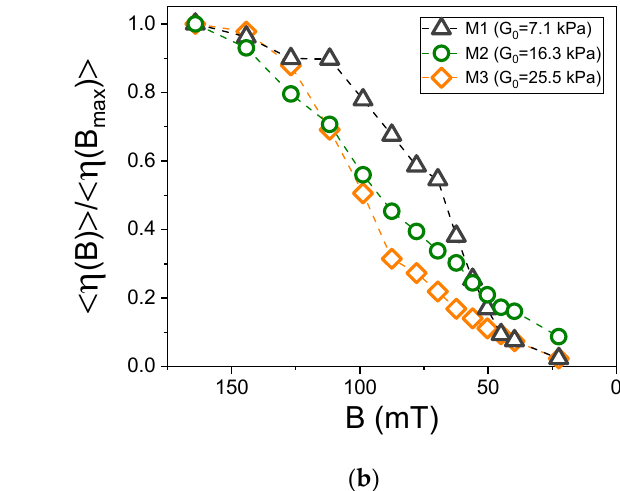
Figure 5. ( a ) Measured diffraction efficiency < 𝜂 > as a function of magnetic field B for sample M2. ( b ) Normalized diffraction efficiency < 𝜂 ( B )>/< 𝜂 ( B max )> as a function of magnetic field B for three MAE samples with different matrix softness.